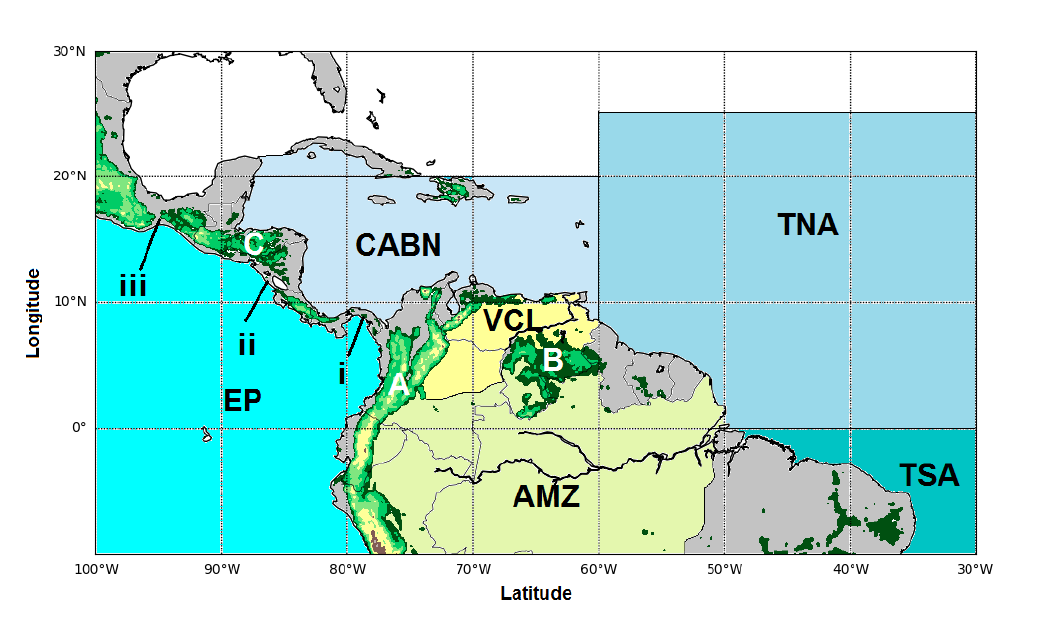
Figure 1. Map of northern South America and Meso-America depicting the regions used in the description of the circulation. Mountain ranges: ( A ) The Andes, ( B ) Guiana Shield, ( C ) Mountains of Central America. Oceans: TNA Tropical North Atlantic, TSA Tropical South Atlantic, CABN Caribbean Sea, EP Estern Pacific. Isthmus: ( i ) Panama, ( ii ) Papagayo, ( iii ) Tehuantepec. Regions: VCL Venezuelan-Colombian Llanos, AMZ Amazon basin.